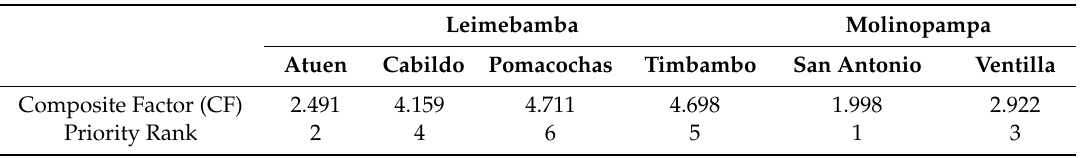
Table 10. Final priority rank based on the Composite Factor (CF) value of the four HAL-MWs in Leimebamba and two HAL-MWs in Molinopampa (Amazonas,